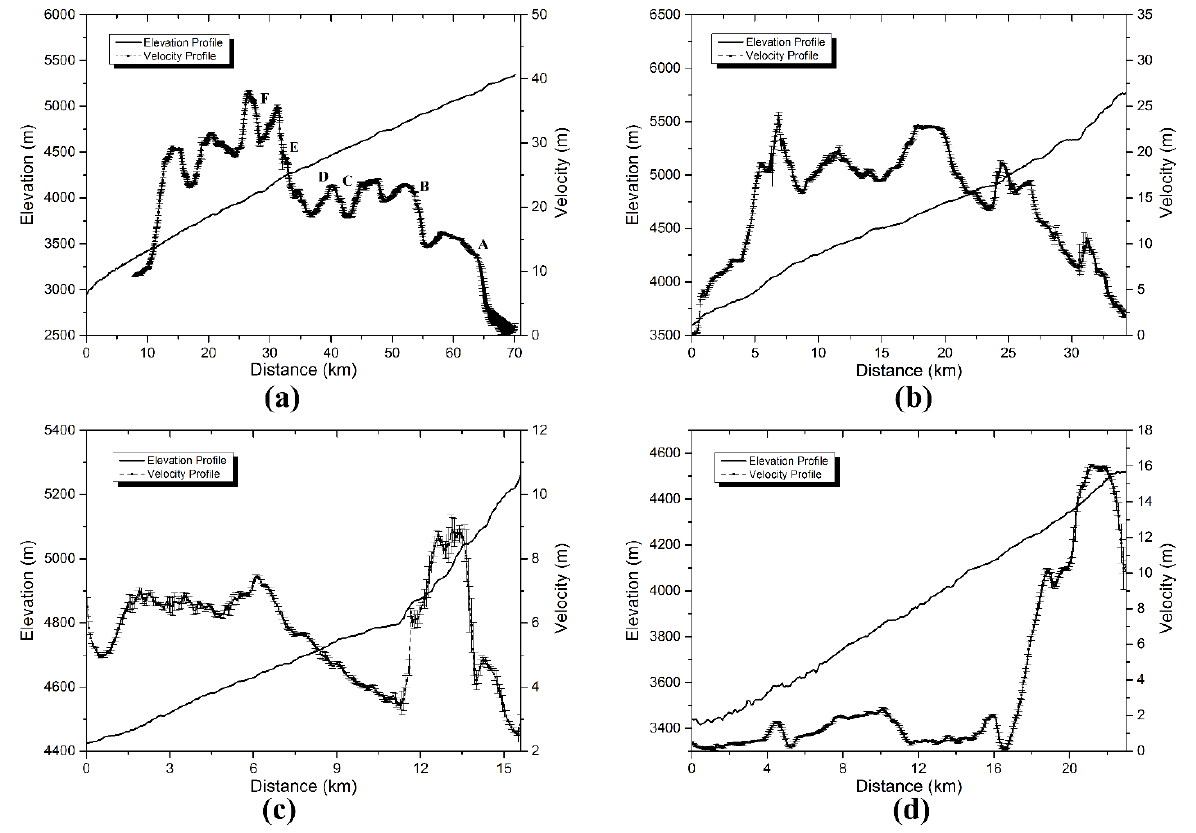
Figure 6. Profiles of glacier surface motion in 46-day and their corresponding elevation variations. ( a ) Fedchenko Glacier; ( b ) Grumm-Grzhimaylo Glacier; ( c ) Nalivkina Glacier; ( d ) Bivachny